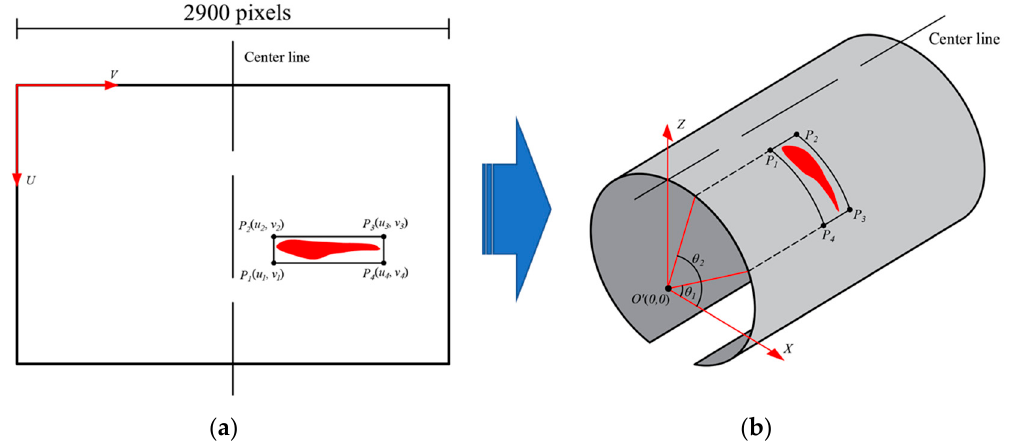
Figure 14. Obtaining the tunnel leakage location in 3D space: ( a ) water leakage positioning on the 2D image, and ( b ) transforming the 2D coordinates into 3D space.